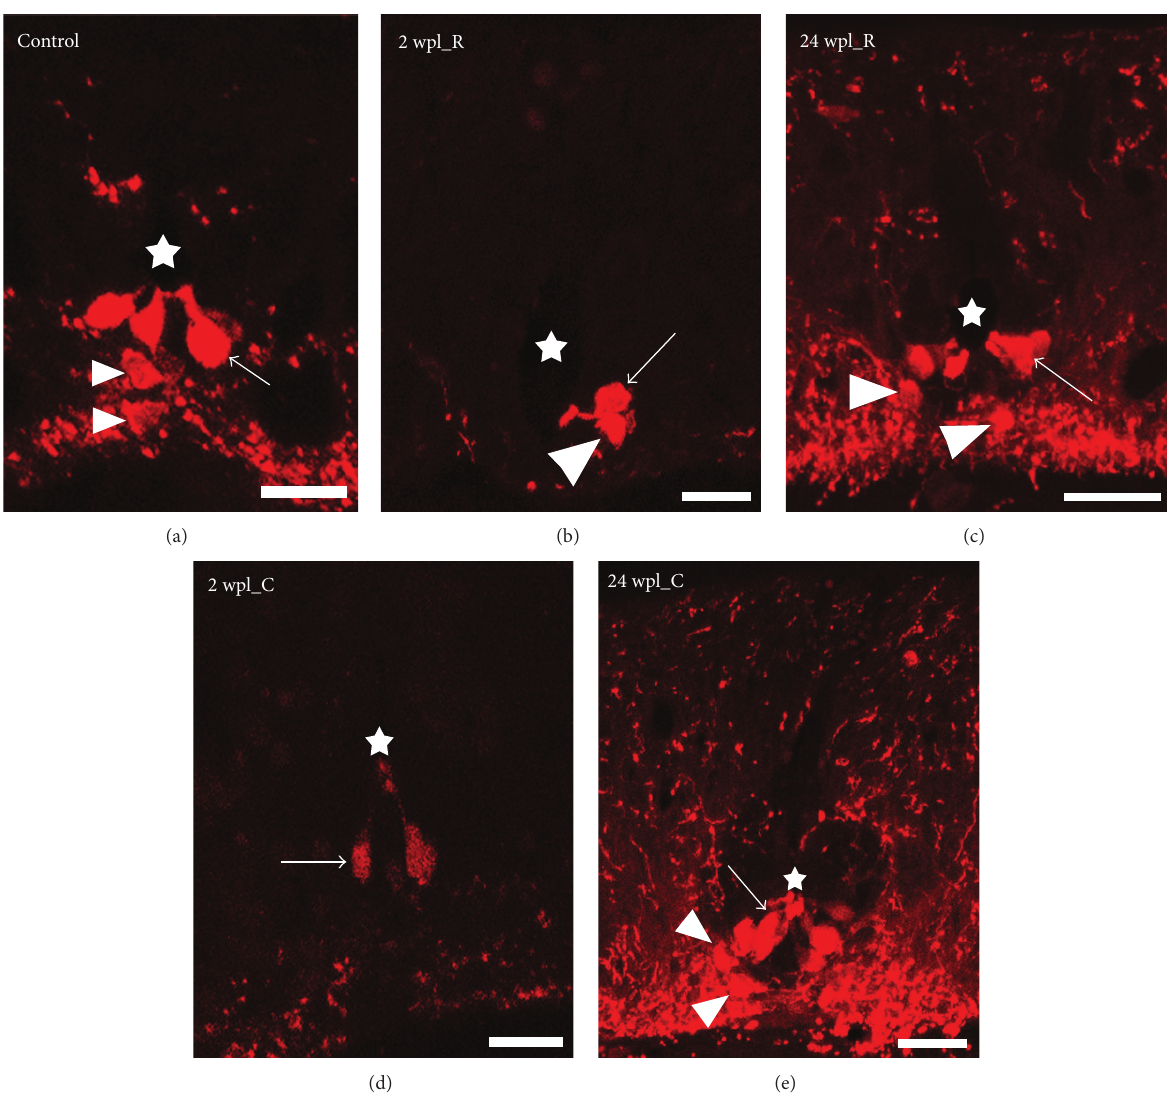
Figure 1: Confocal photomicrographs of transverse sections of the spinal cord showing details of the dopaminergic cells in control and lesioned animals. (a) Dopaminergic cells in a control unlesioned larva. ((b), (d)) Dopaminergic cells in a 2 wpl larva, rostral (b) and caudal (d) to the site of injury. ((c), (e)) Dopaminergic cells in a 24 wpl larva, rostral (c) and caudal (e) to the site of injury. CSFc cells (arrows), VM cells (arrowheads), star points to the central canal. In all photomicrographs dorsal is at the top. Scale bars = 25 𝜇